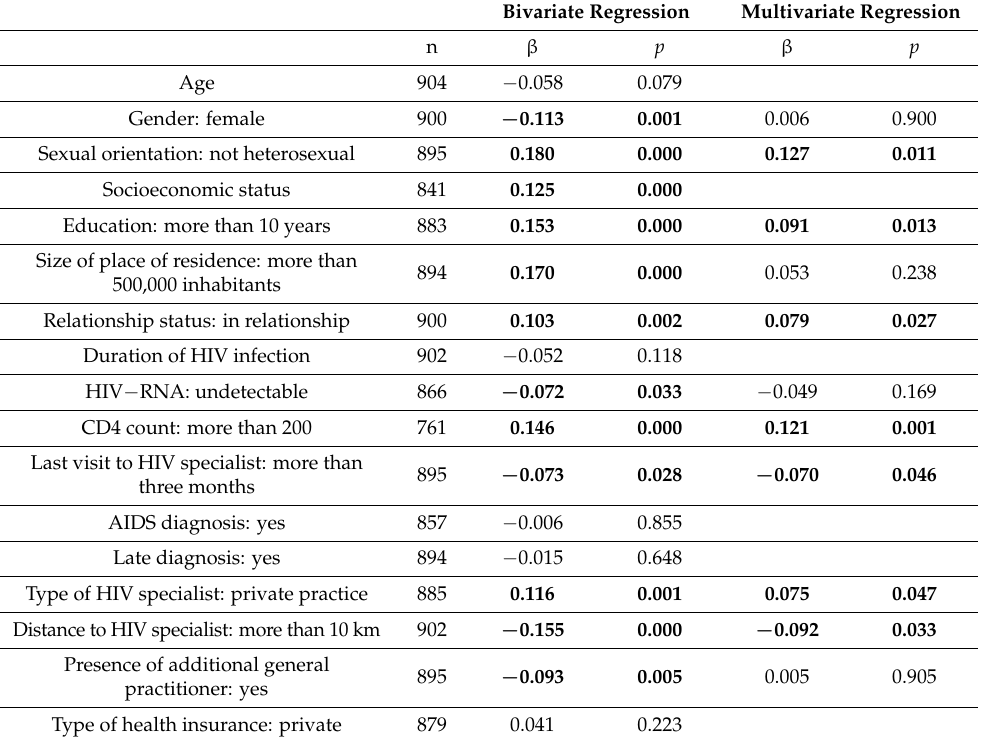
Table 4. Factors associated with vaccination coverage among people aging with HIV in Germany (2013, n = 904). Bivariate Regression Multivariate Regression n β p β